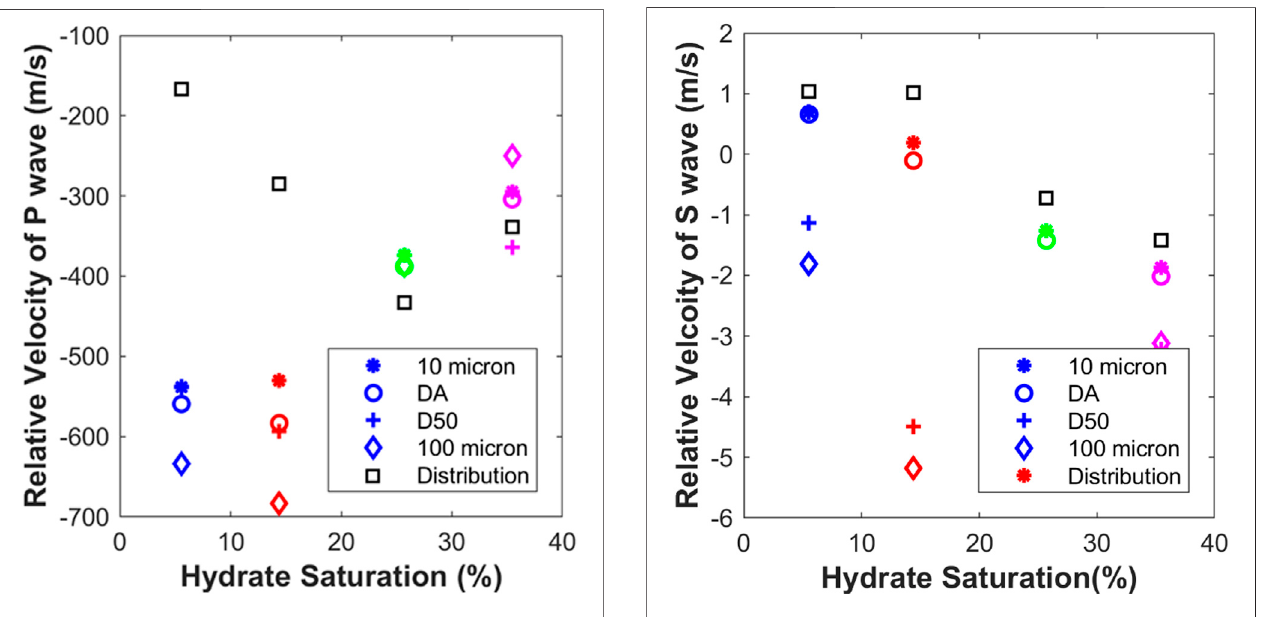
Frontiers in Earth Science |